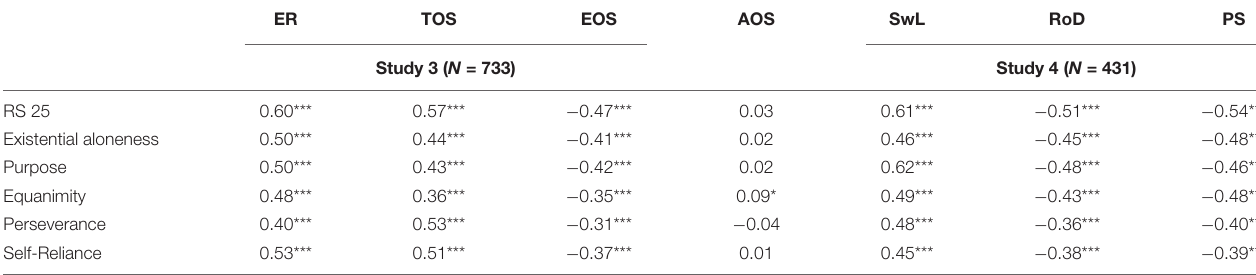
Perseverance 0.40***